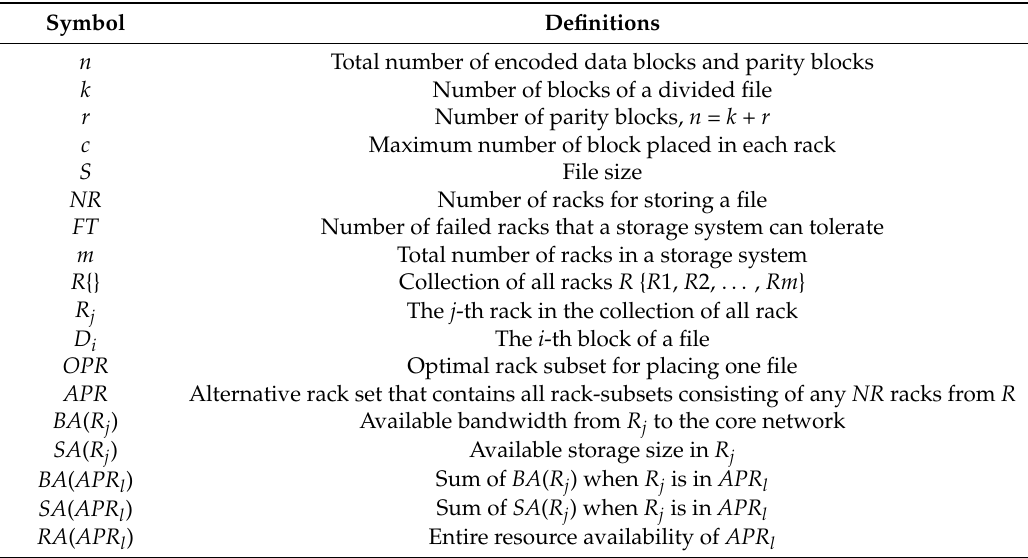
Table 1. Mathematical symbols and definitions used in this